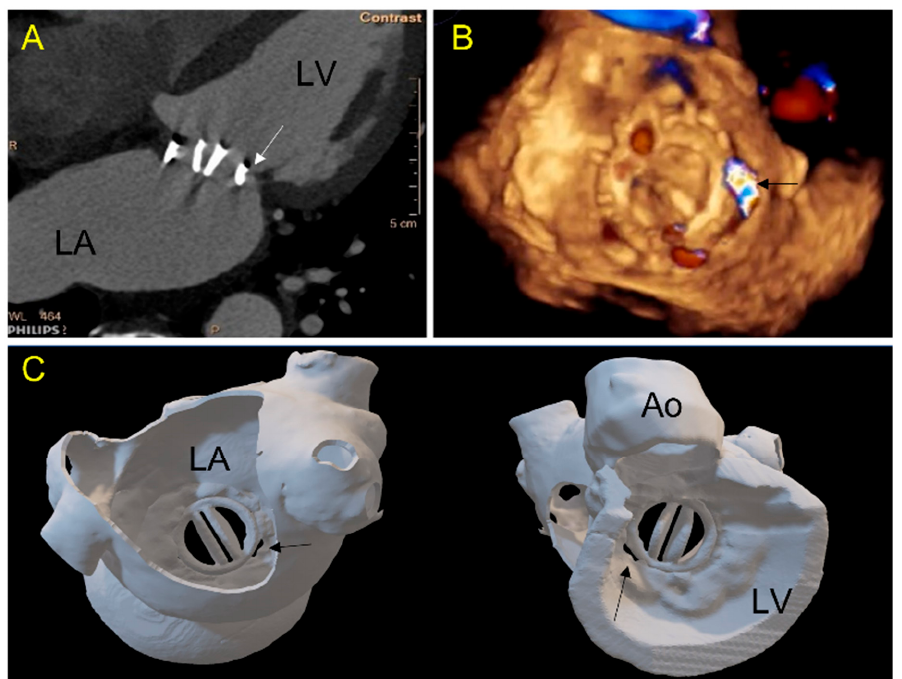
Figure 2. Case 1: A 71-year-old patient with a mechanical mitral valve and a large single postero- septal paravalvular leak (PVL). ( A ) 2D-CT view: a gap (arrow) is seen between the prosthetic ring and the ventricular wall; ( B ) 3D TEE view of the mitral valve from the left atrium showing in 3D color-doppler a posterior septal PVL (arrow); ( C ) 3D printed model showing the double-leaflets mitral mechanical prosthesis in atrial ( left panel , in a same view as ( B )) and ventricular view ( panel right ). The PVL location and morphology are well depicted. (LA-left atrium, LV-left ventricle, Ao-aorta).